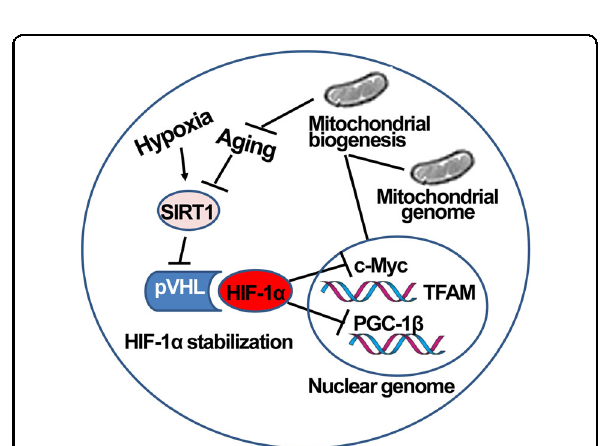
Fig. 3 Regulation of mitochondrial biogenesis and aging by SIRT1 and HIF-1 α . During the aging process, the activity of SIRT1 in the nucleus is reduced, which decreases pVHL levels and subsequently stabilizes HIF-1 α . Activated HIF-1 α reduces c-Myc activity and subsequently reduces the transcription of TFAM, which is required for replication, transcription, and maintenance of